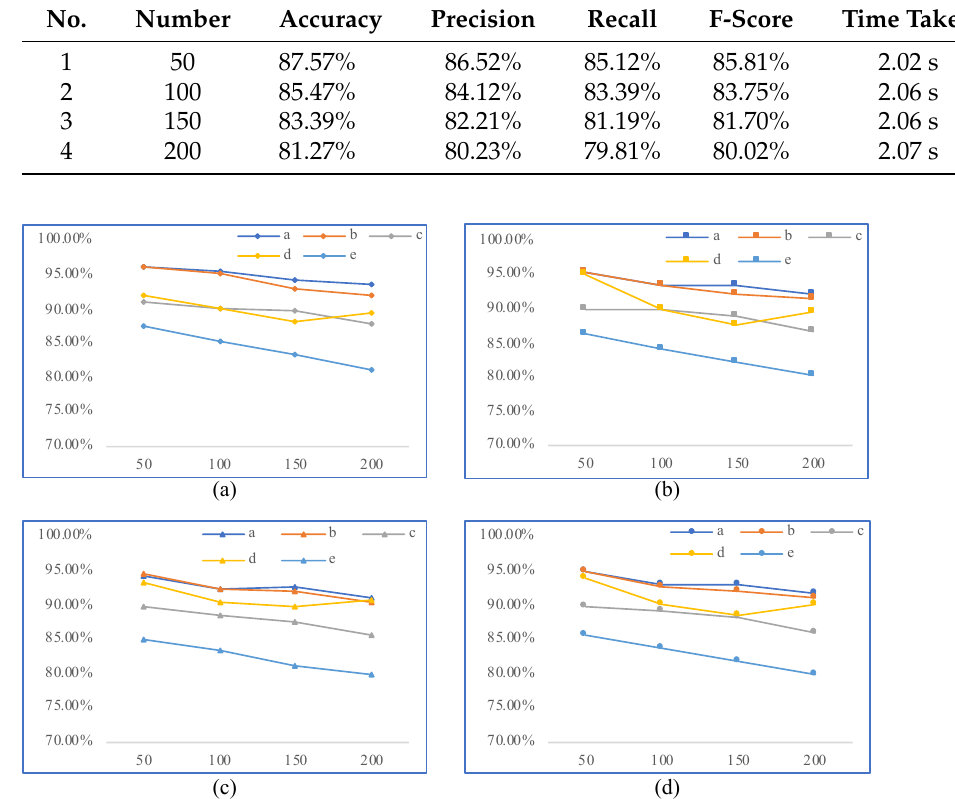
Figure 12. ( a ) Accuracy result graph of the commands. ( b ) Precision result graph of the commands. ( c ) The resulting graph of the recall value of the commands. ( d ) F-score result graph of the commands The following points can be obtained from the experimental result